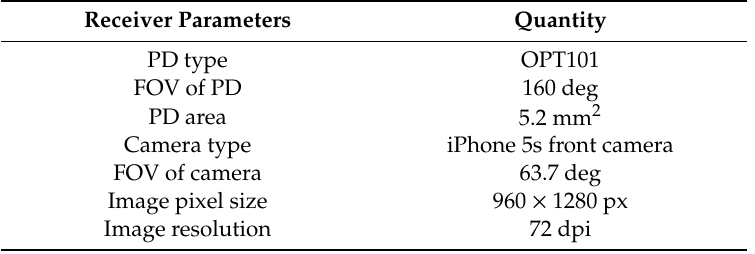
Figure 3. The mobile robot and receiver module: ( a ) Mobile robot and ( b ) Receiver module installed on the mobile robot. Table 1. Receiver Parameters. PD: photodiode, FOV: field of view